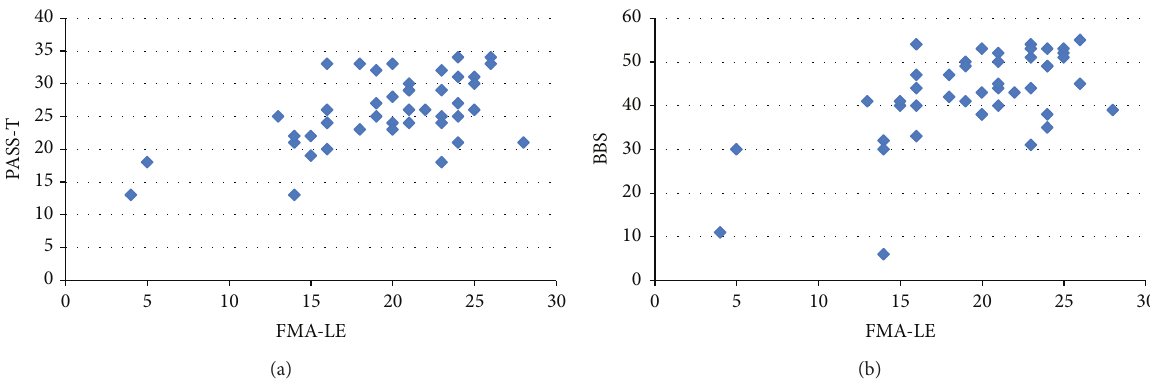
Figure 3: (a) Showing the relation between the total score of Fugl-Meyer Assessment: lower extremity (FMA-LE) and Postural Assessment Scale for Stroke (PASS-T). (b) Showing the relation between the total score of Fugl-Meyer Assessment: lower extremity (FMA-LE) and total scores of Berg Balance Scale